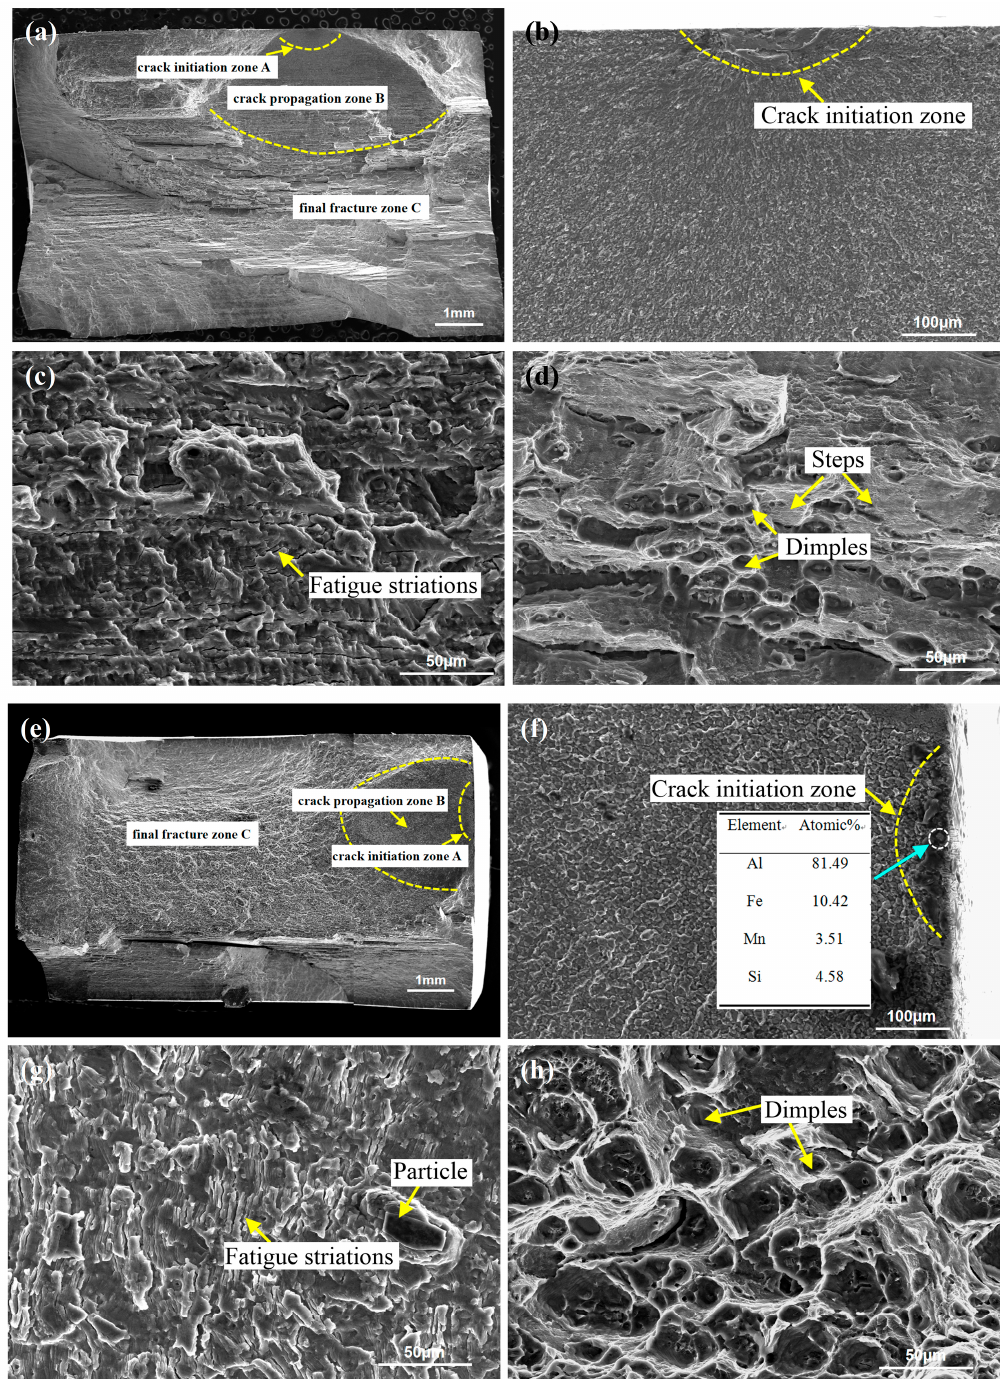
Figure 10. Fracture morphologies of FSW and UAFSW at the maximum stress of 250 MPa: ( a ) FSW macrostructure; ( b ) crack initiation zone from Figure 10a; ( c ) crack propagation zone from Figure 10a; ( d ) final fracture zone from Figure 10a; ( e ) UAFSW macrostructure; ( f ) crack initiation zone from Figure 10(e); ( g ) crack propagation zone from Figure 10e; and ( h ) final fracture zone in Figure 10e.